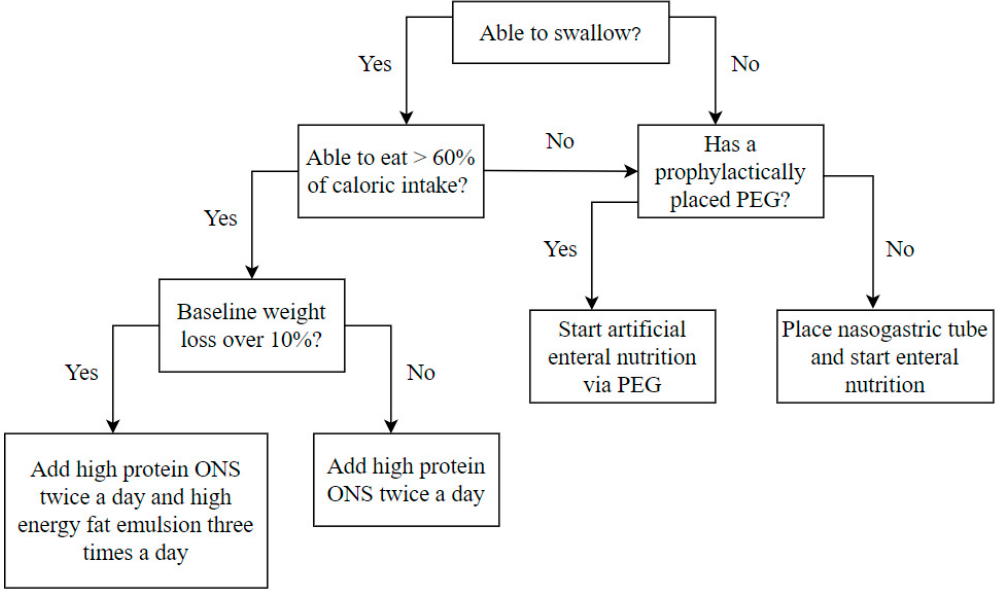
Figure 1. Nutrition algorithm included in the nutritional care program performed at the beginning and every 14 days during the treatment period. ONS oral nutritional supplements, PEG – percutaneous endoscopic gastrostomy.